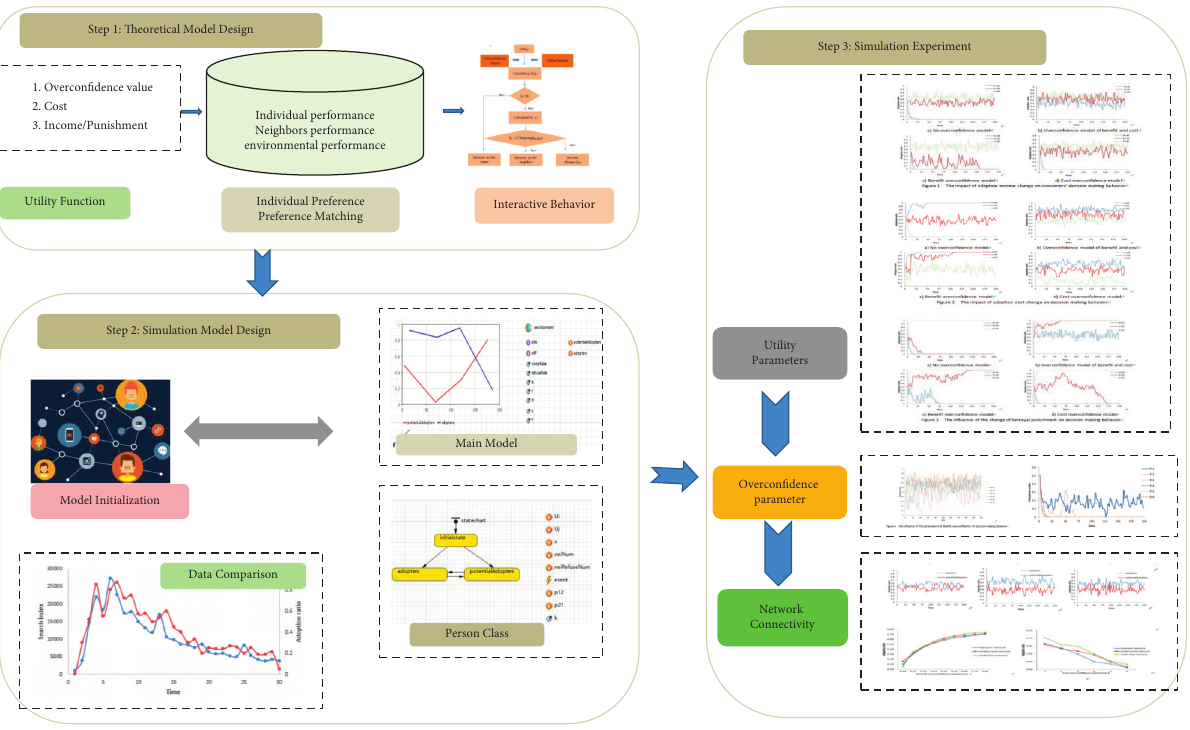
Figure 1: The research